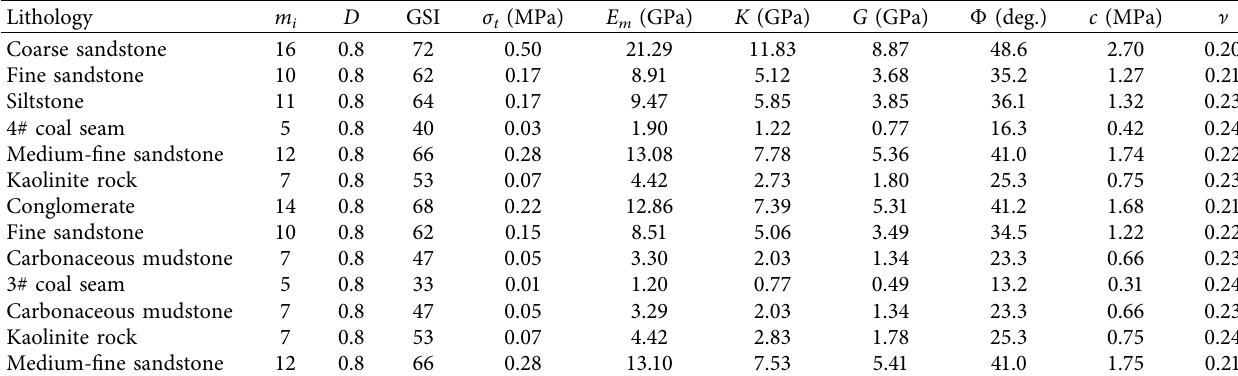
Table 1: Rock mass parameters.